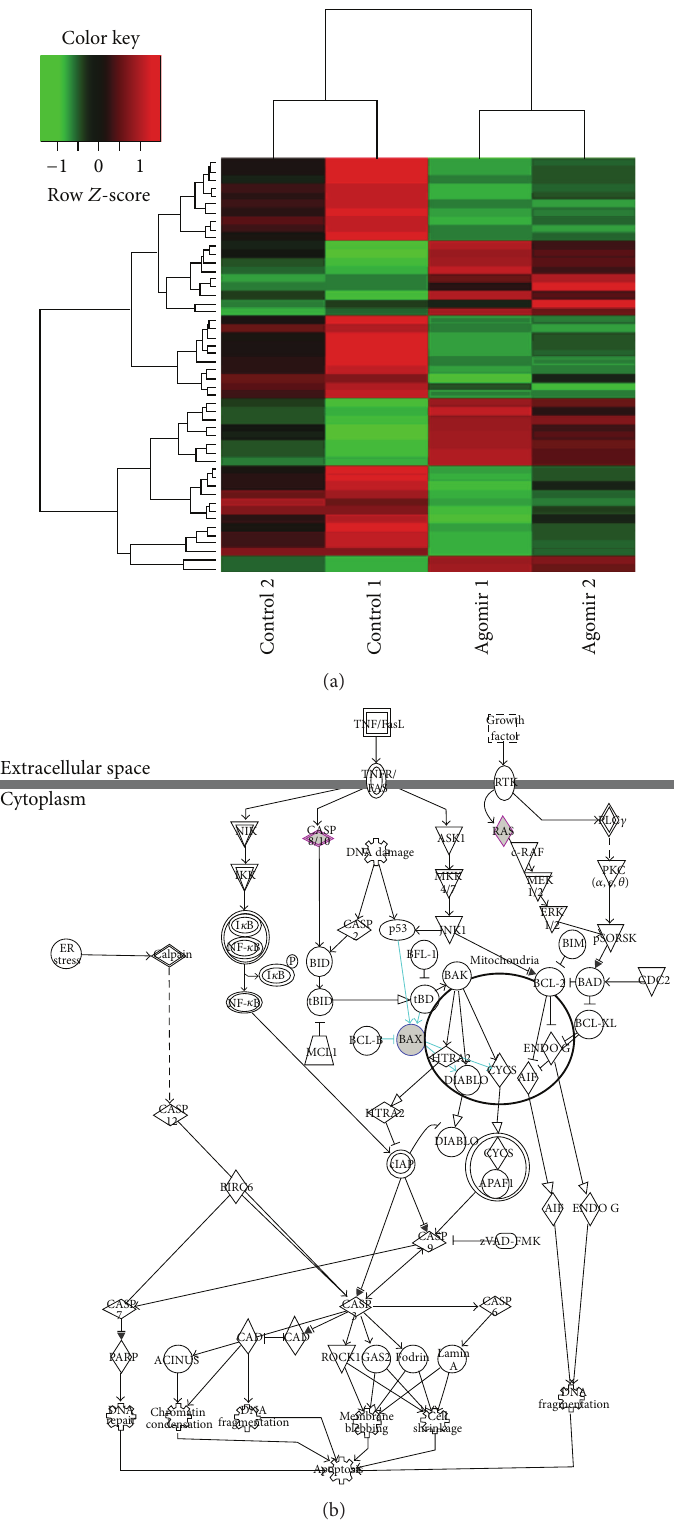
Figure 3: Heat map visualization and pathway analysis of differentially expressed genes. (a) Hierarchical clustering and heat map